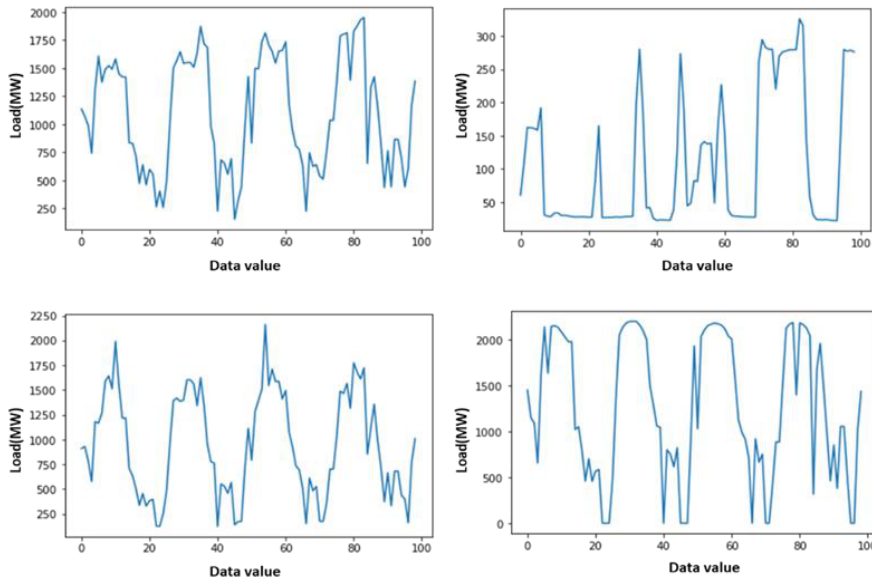
Figure 4. Actual data values of four different